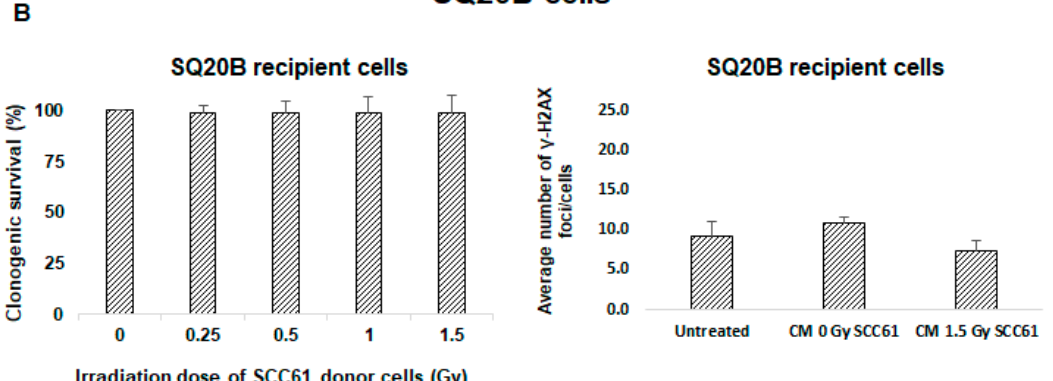
Figure 2. Bystander effectors are radio-induced in SQ20B cells. To assess whether SQ20B cells could induce bystander factors, culture mediums were exchanged between SCC61 and SQ20B cells and clonogenic survival and induction of γ -H2A.X foci were evaluated. ( A ) SCC61 recipient cells were incubated with conditioned medium from SQ20B donor cells, and ( B ) SQ20B recipient cells were cultured in medium from SCC61 donor cells. The results are the mean ± SD of three experiments performed in triplicate. * p < 0.05, ** p < 0.01, compared with untreated cells.